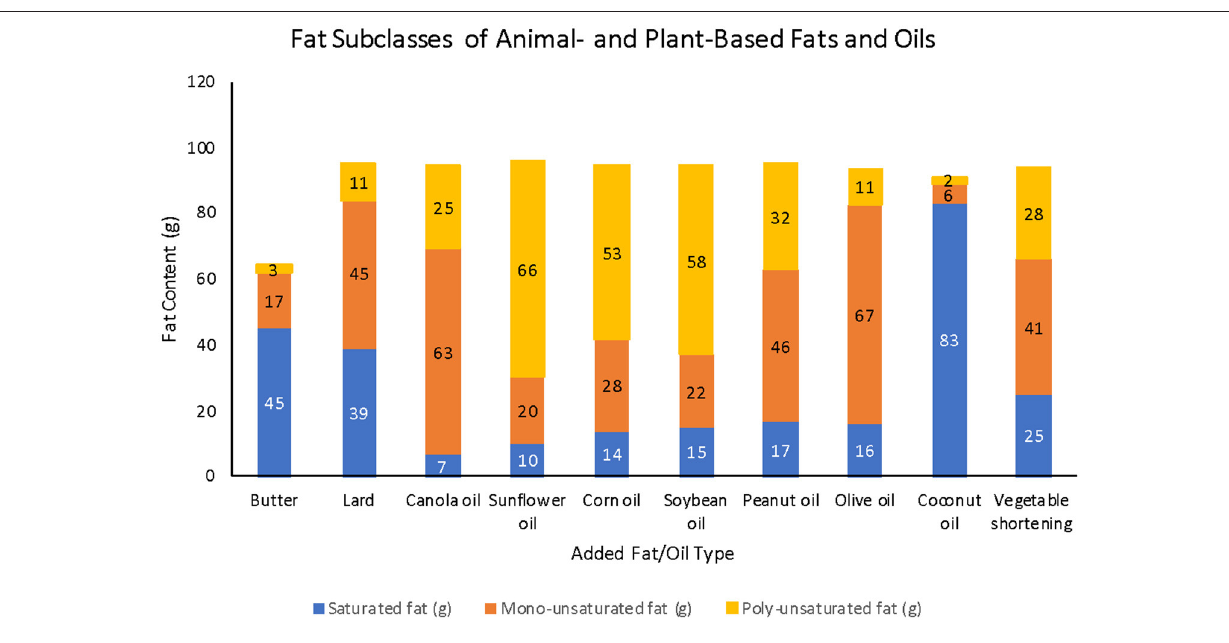
1970 to 2010, total grain availability (including rice) per capita increased 41% (94.8–134